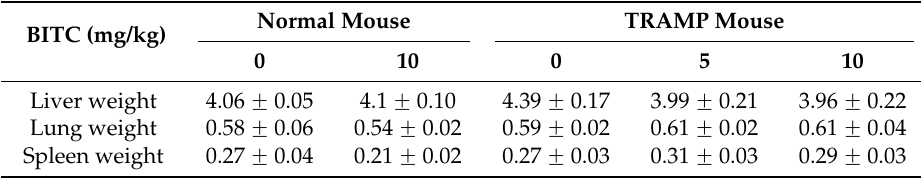
Table 1. Effect of BITC on organ weights in mice.